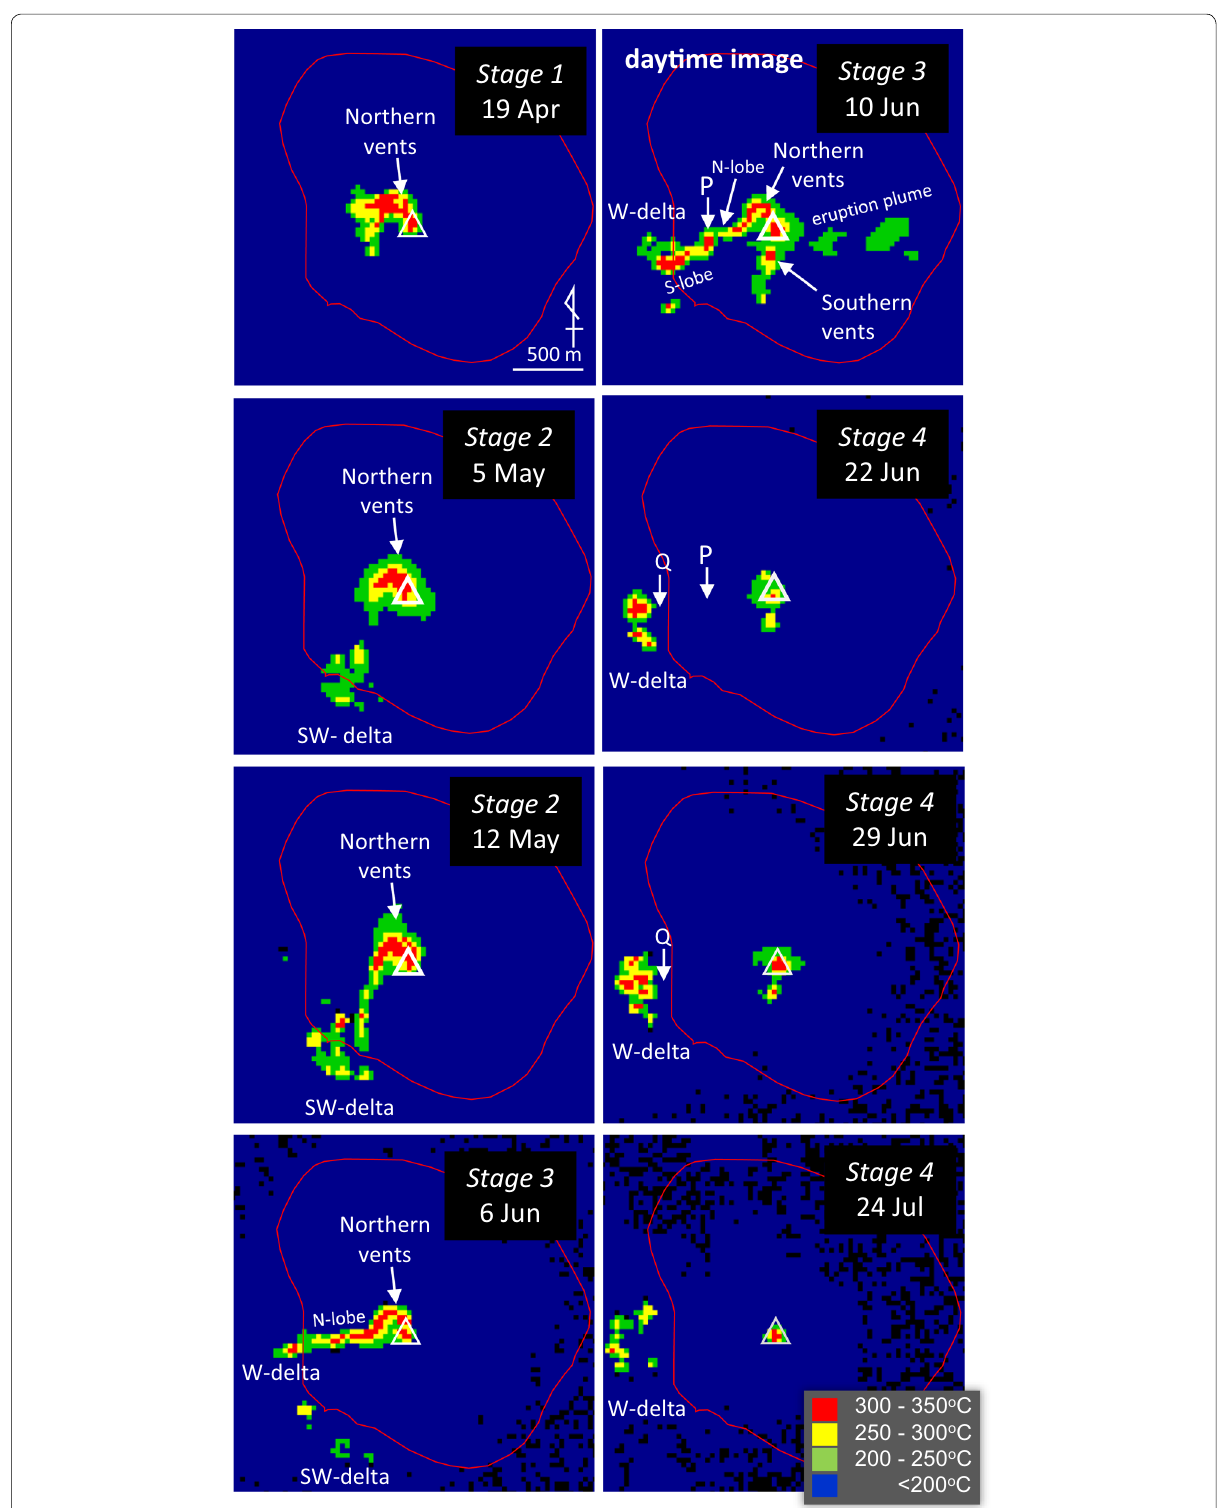
Fig. 6 Pixel-integrated temperature of the 2.2-µm images of Landsat-8 OLI between 19 April and 24 July. These are nighttime images except for 10 June. The white triangles mark the cinder cone